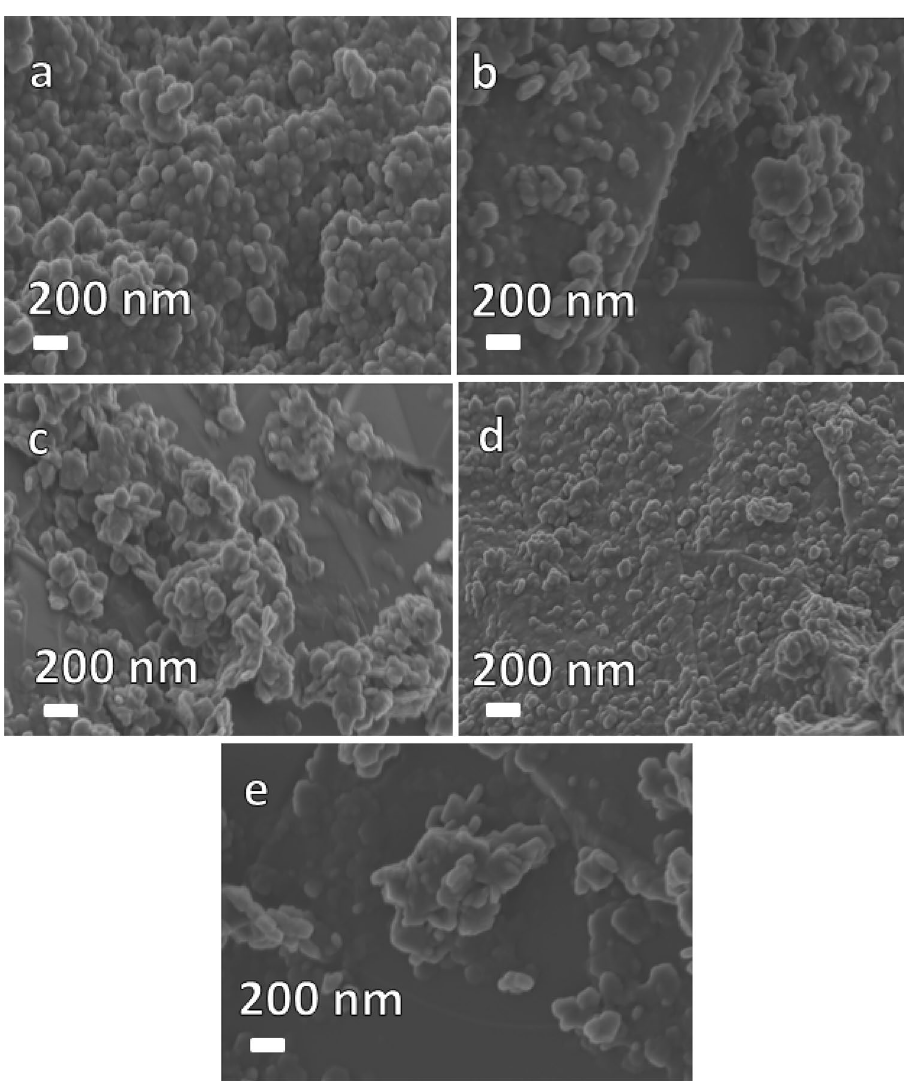
Fig. 2 SEM images of a NiCoMn-TH (pristine), b NiCoMn-TH/100 mg GF, c NiCoMn-TH/150 mg GF, d NiCoMn-TH/200 mg GF, and e NiCoMn-TH/250 mg